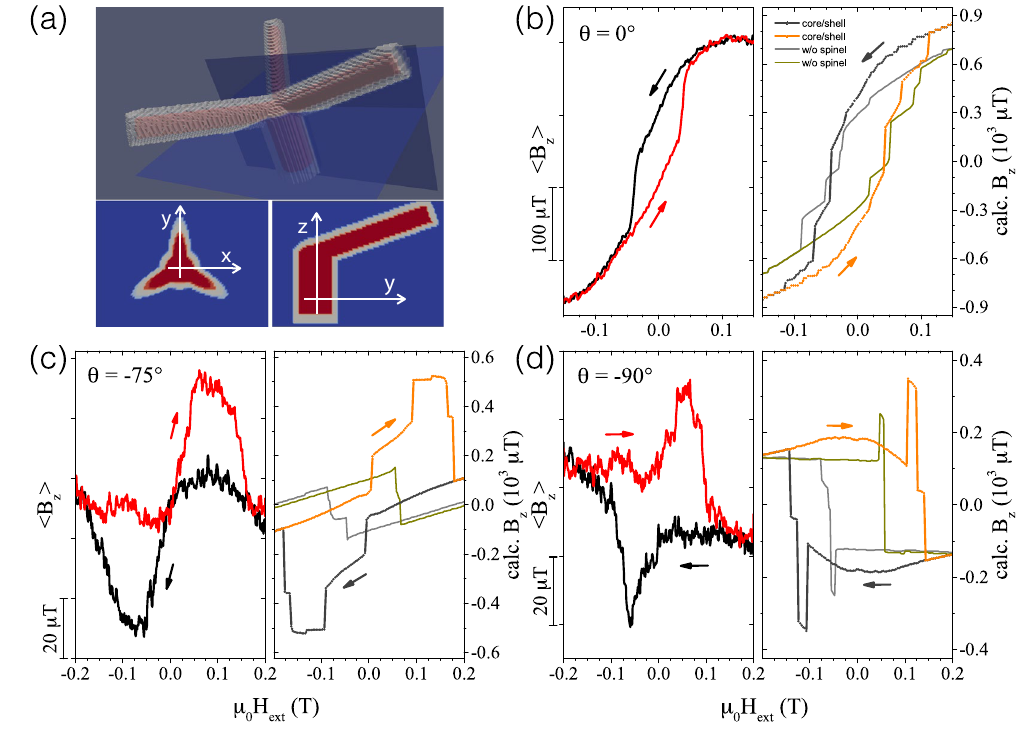
Figure 6. Micro-Hall magnetometry measurement results and micromagnetic simulations for nano-trees. ( a ) 3D-view and cross sections of nano-tree assuming a Co 3 Fe core (red) and Co 2 FeO 4 spinel shell (gray), according to scenario 2 (core-shell structure). ( b – d ) Comparison of the magnetic hysteresis loops at T = 30 K and micromagnetic simulations for T = 0 K with or without core-shell structure (as indicated) for selected angles 0°, − 75° and − 90°, respectively. Arrows indicate the direction of field